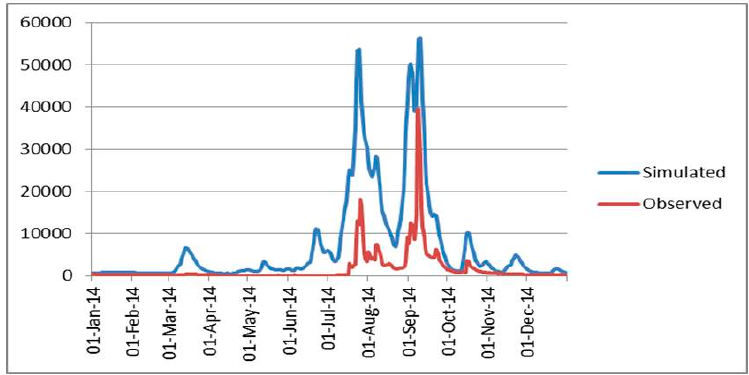
Figure 9. Simulated and observed discharge graph.